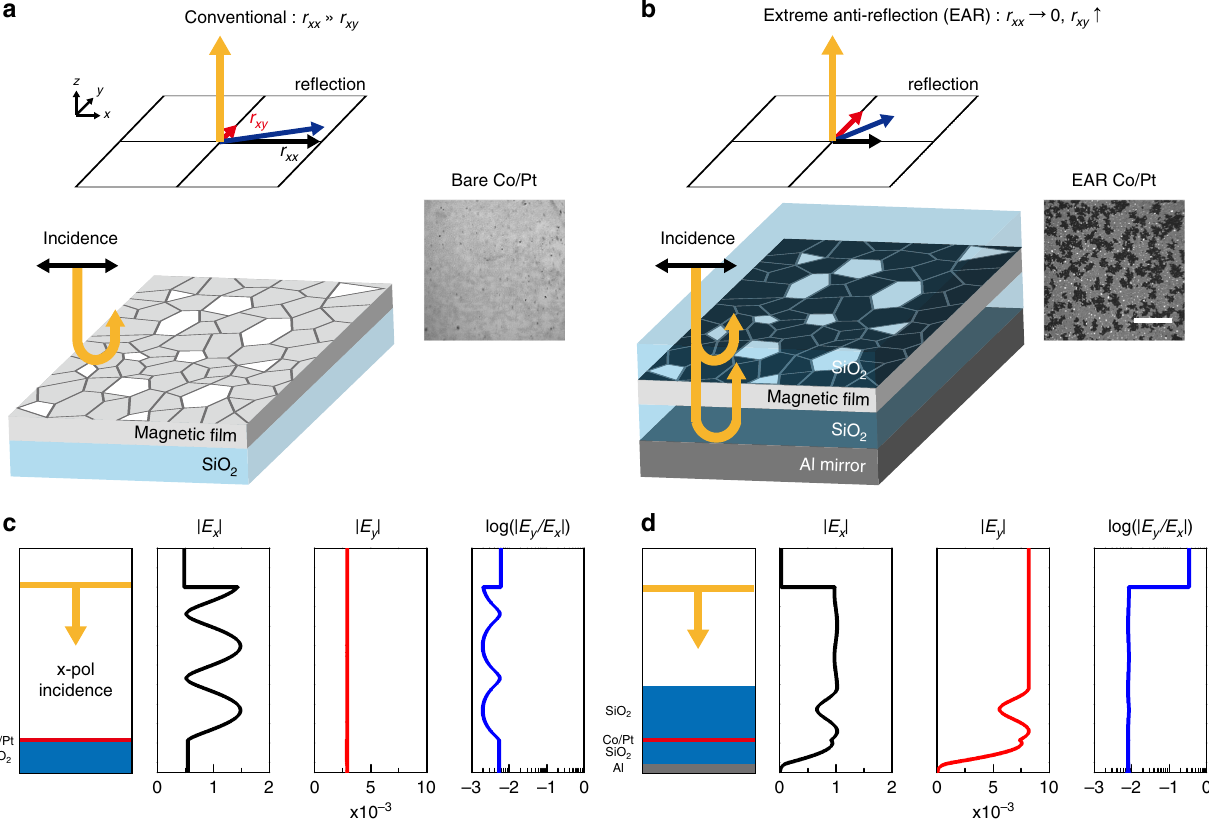
Fig. 1 Principle of EAR-enhanced MOKE microscopy. a , b Schematic of the a conventional and b EAR-enhanced MOKE microscopy. The cooperation of the bottom Al re fl ector, phase-matching SiO 2 layer, and phase-compensation SiO 2 layer presents the magnetic material with EAR (right panel). EAR not only suppresses the non-MO re fl ection of the incident fi eld ( E x ) but also enhances the generation of the MO fi eld ( E y ). The combination of the suppressed ( r xx ) and enhanced ( r xy ) dramatically improves the performance of the MOKE microscopy. Insets, MOKE microscopy images of the bare and EAR Co/Pt fi lms. Scale bar, 50 μ m. c , d Simulated electric fi eld amplitude pro fi les of the bare Co/Pt ( c ) and EAR Co/Pt ( d ) fi lms under the normal incidence of the x - polarised planewave. The yellow line represents the position of the planewave source. The wavelength of light is 660 nm. The MO Kerr amplitude, the ratio between | E x | and | E y |, is plotted on the log